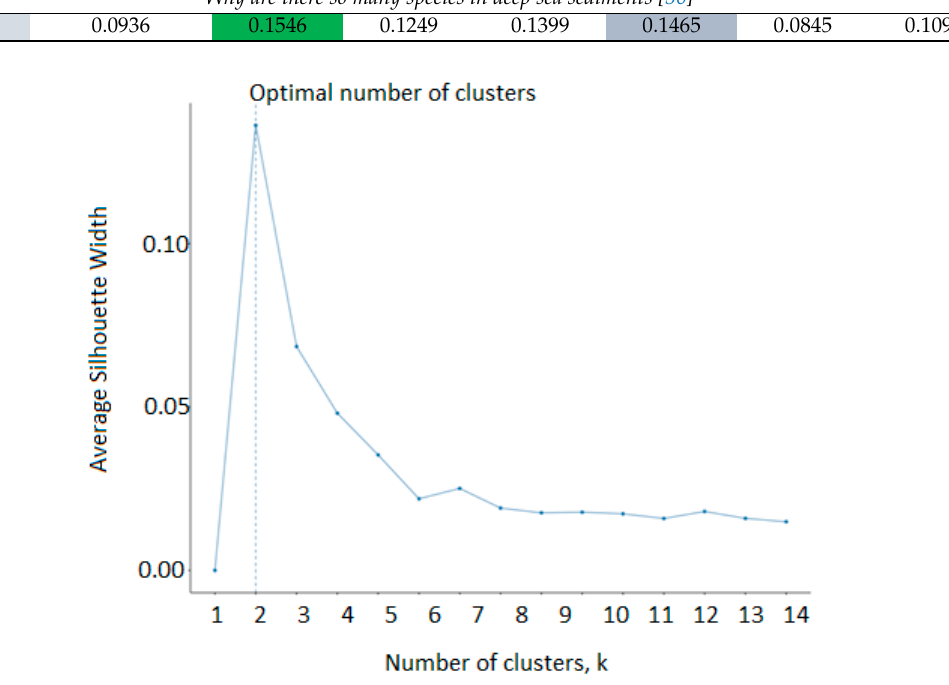
Figure 15. Silhouette Profile demonstrating the optimal k for clustering. Analysis of the peak in the silhouette profile and the level of concordance between clusters and manual labels within the heatmap could thus possibly indicate the existence of a limited statistical basis underlying the results of the manual labeling strategy, despite ambivalent cluster distributions for several labels. The heat map in Figure 17 demonstrates the co-localization between LDA topics and the manually assigned Biomimicry Taxonomy labels, where we observe a potentially significant correlation between the “Modify” label and LDA Topic 4, as well as a somewhat discernable scattered concentration of the manually assigned labels across LDA